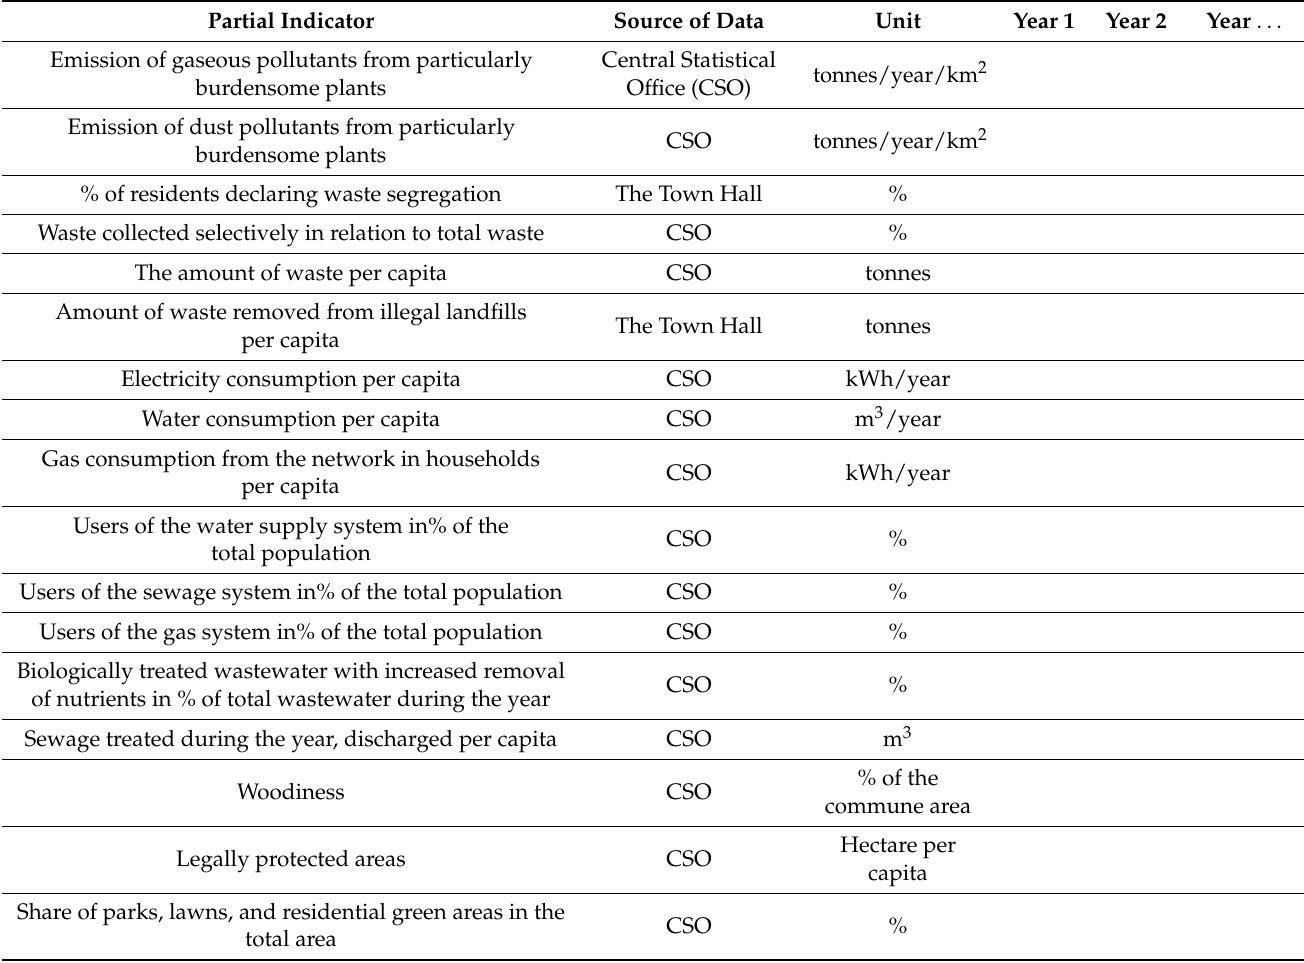
Table 4. Area 3 on air quality, environmental awareness, and sustainable resource